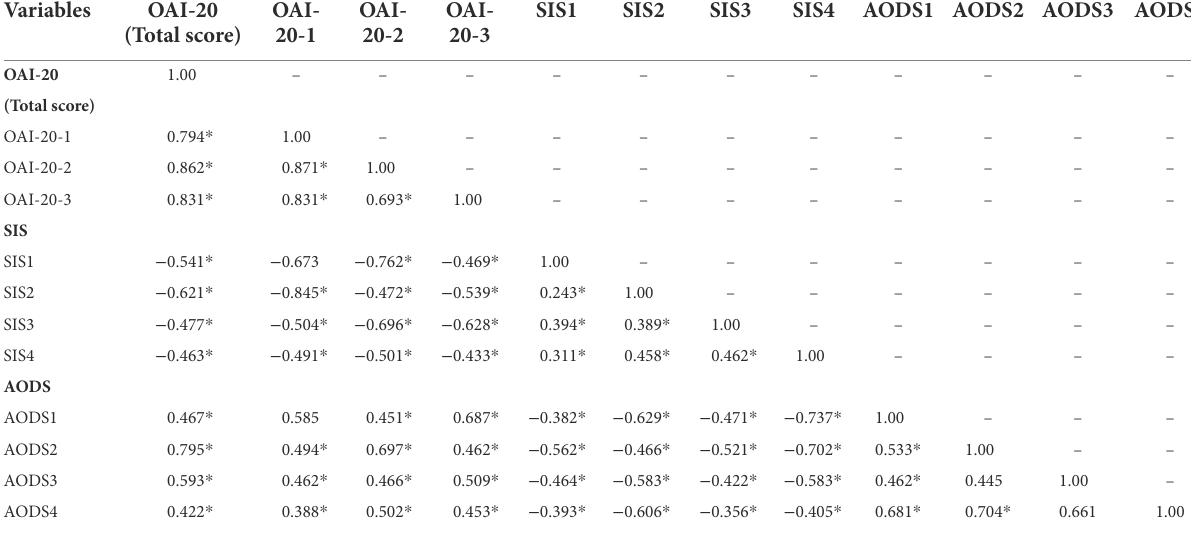
TABLE 4 Spearman correlation coefficients of OAI-20, SIS and AODS Score ( r , N = 259).